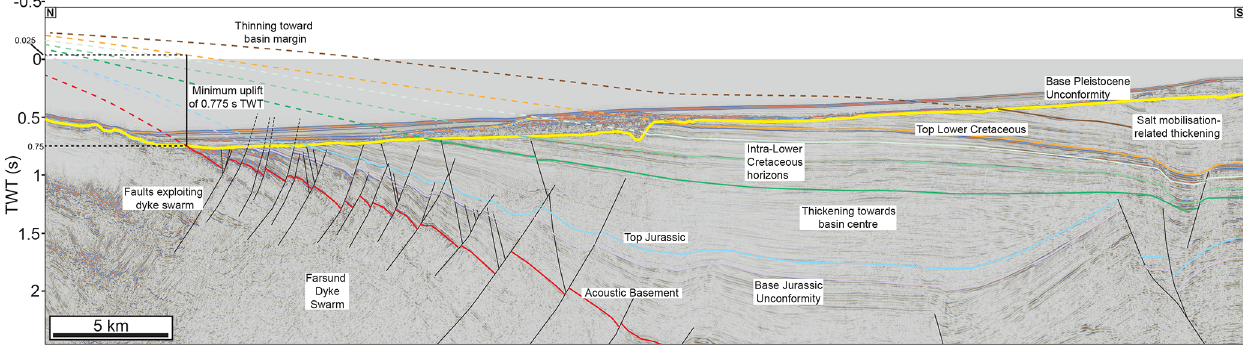
Figure 7. Interpreted seismic section across the Farsund Basin and Agder Slope, showing subcrop projections, taking into account underlying stratal geometries, and associated uplift. See Fig. 2 for